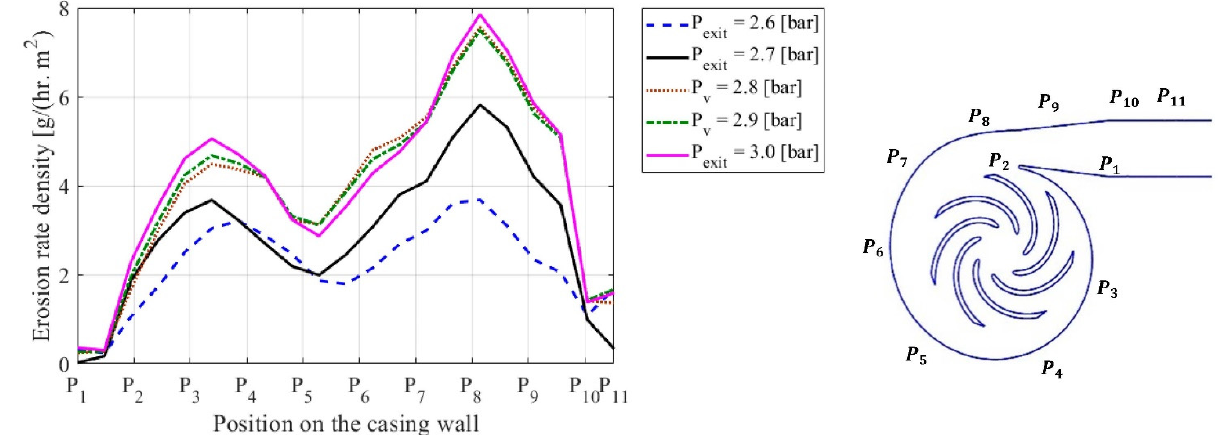
Figure 19. Variation of concentration of particles along the casing wall with different values of exit pressure heads.